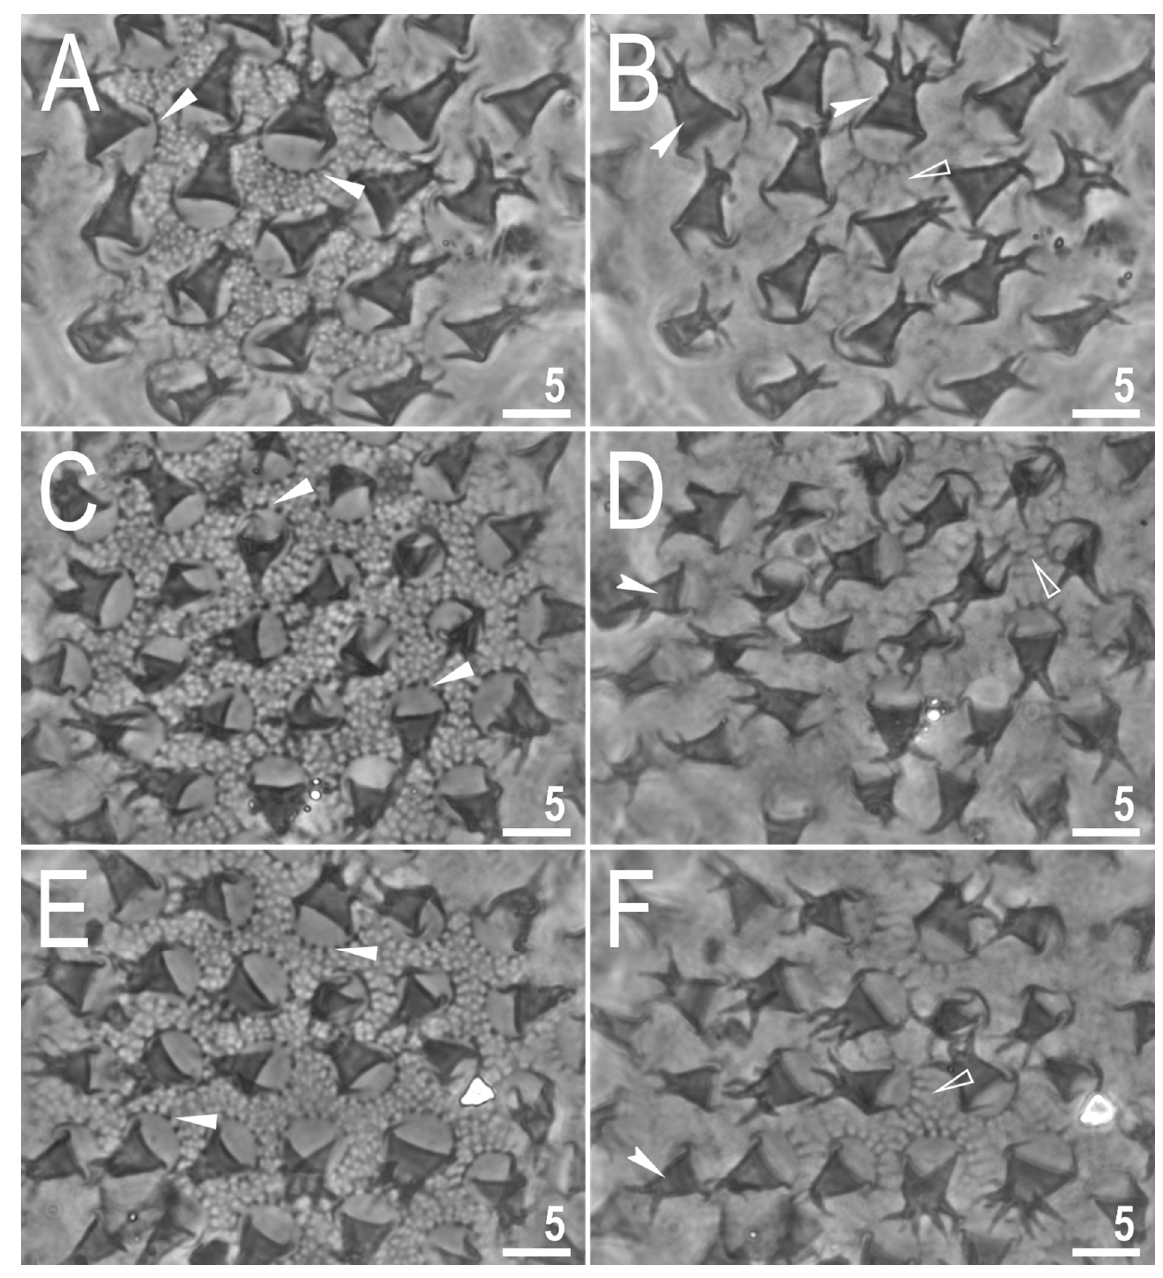
Figure 9. Mesobiotus marmoreus sp. nov. —PCM images of the egg surface under ×1000 magnification. Each row represents a different egg whereas columns represent different focus levels. Filled flat arrowheads indicate crowns of thickenings around the process bases, empty flat arrowheads indicate extending striae radiating from processes bases, filled indented arrowheads indicate faint thickenings and darkening in processes trunk that in SEM are visible as annulations. Scale bars in μ m.